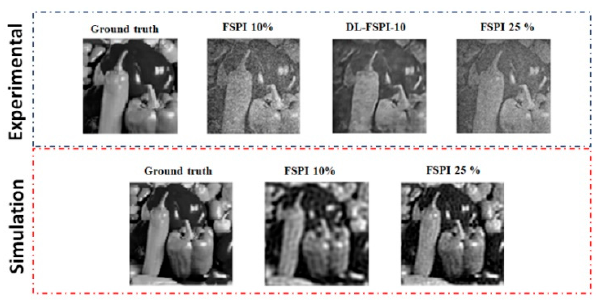
Figure 12. Reconstruction results of experiment-2 (also compared with simulation output).